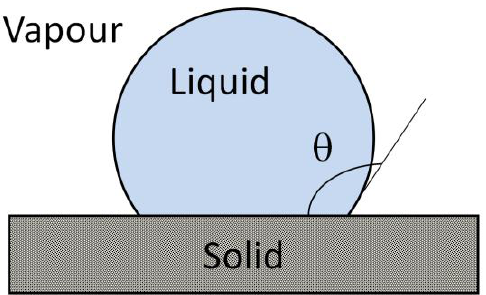
Figure 1. Definition of the equilibrium contact angle θ. For a flat, smooth and chemically homogeneous solid surface, θ is the Young contact angle θ Y